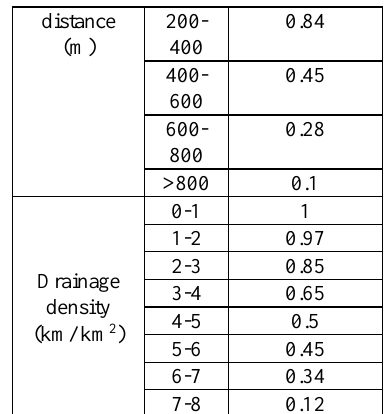
Figure 4. Lithology map of study area